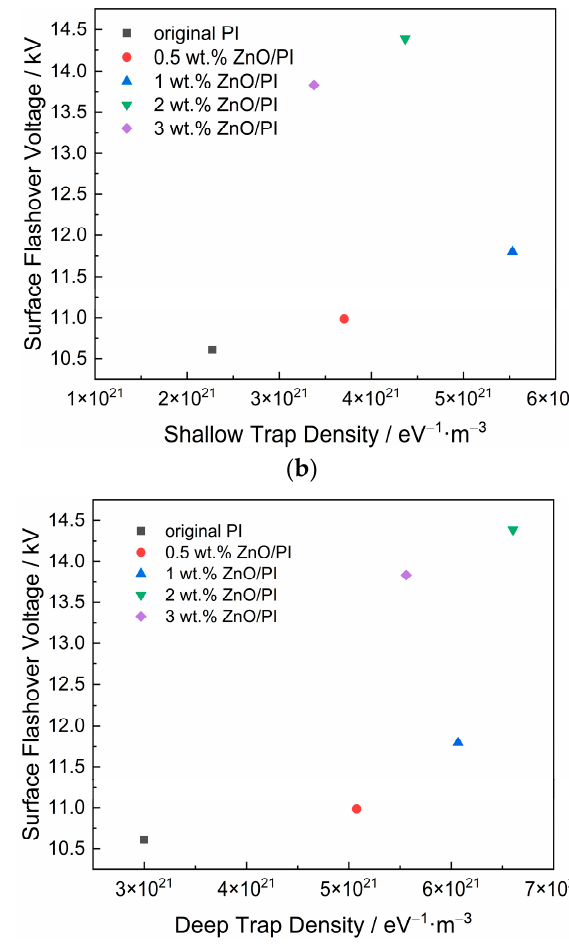
12 of 18 Figure 10. The surface potential decay rate of original PI and 1 wt.% ZnO/PI. Table 4. The carrier mobility variation in composite films with different amounts of nano-ZnO. Sample